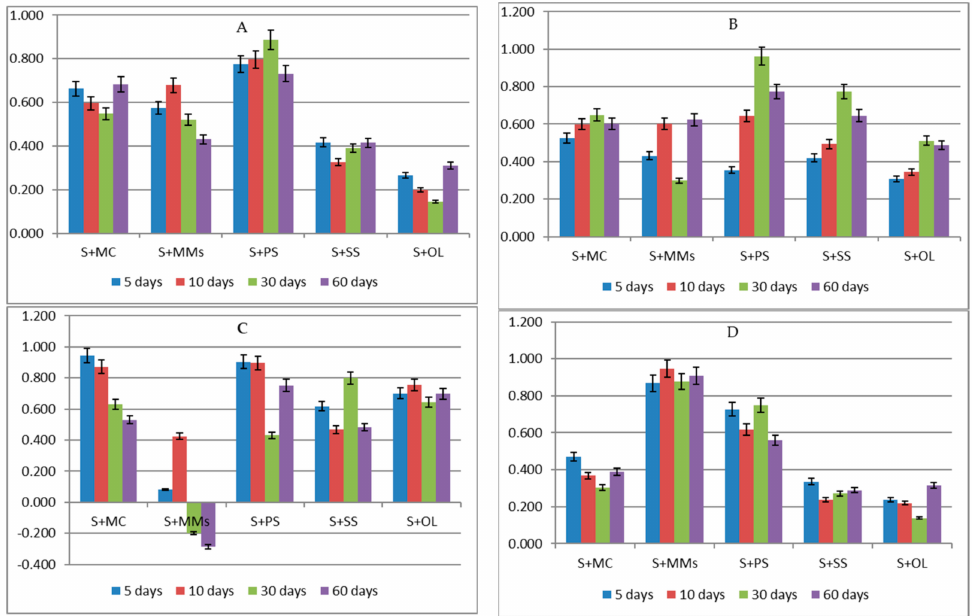
Figure 3. Soil resistance indices ( RS ) of soil enzymes: DEH ( A ); CAT ( B ); AlP ( C ); AcP ( D